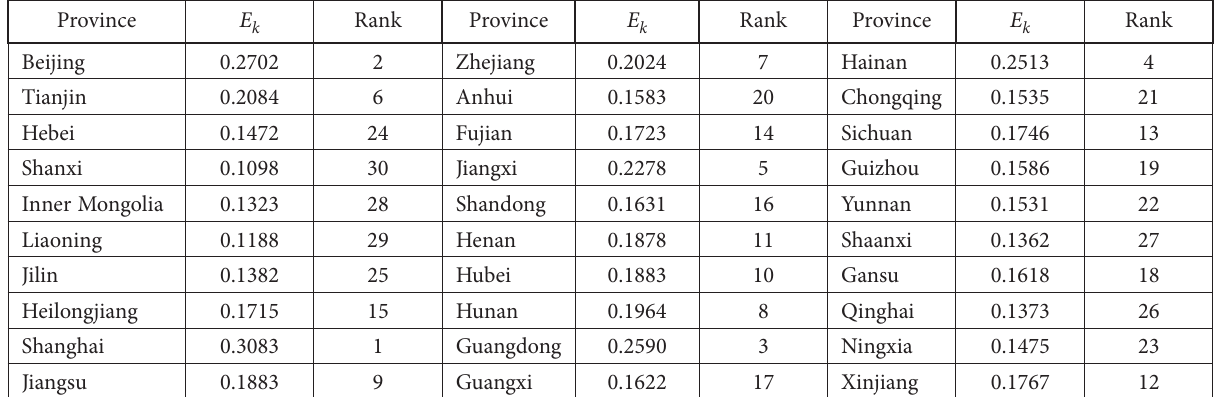
Table 3. The overall efficiency of the provincial real estate industry in China Province